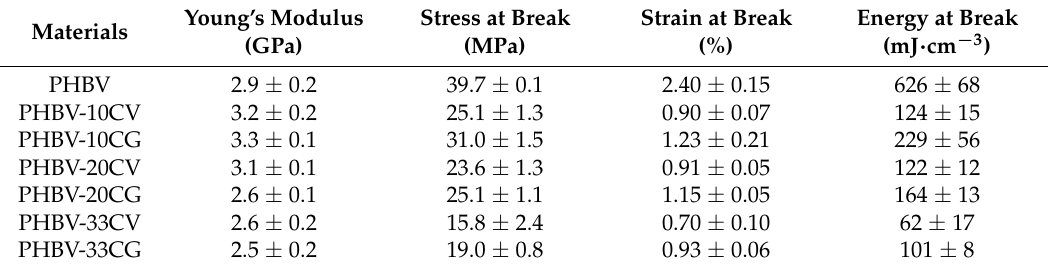
Table 4. Tensile properties (Young’s modulus, nominal stress at break, nominal strain at break, and energy at break) of PHBV-based biocomposites.